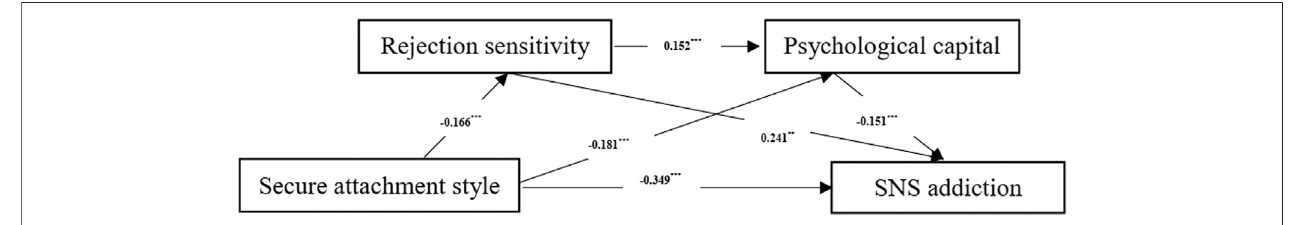
FIGURE 4 | The unstandardized coef fi cients of the